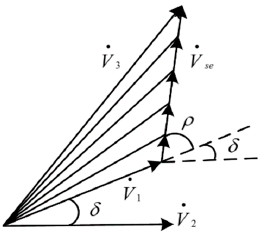
Figure 2. The working principle of the DPFC.